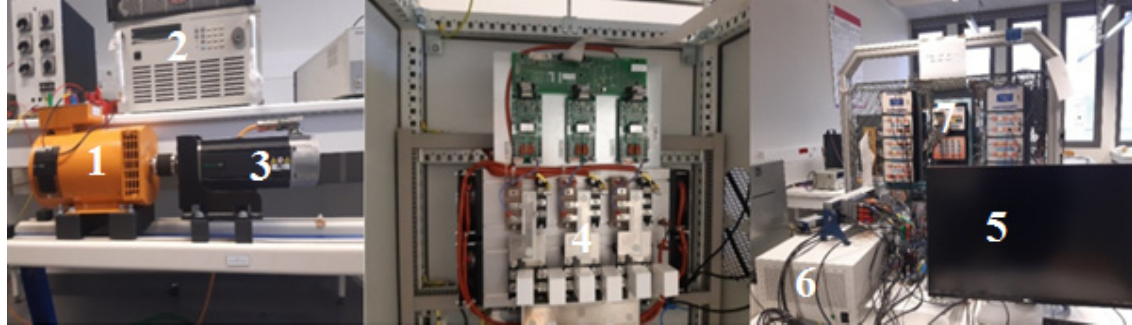
Figure 12. The test bench platform. Table 3. Parameters of DC motor.